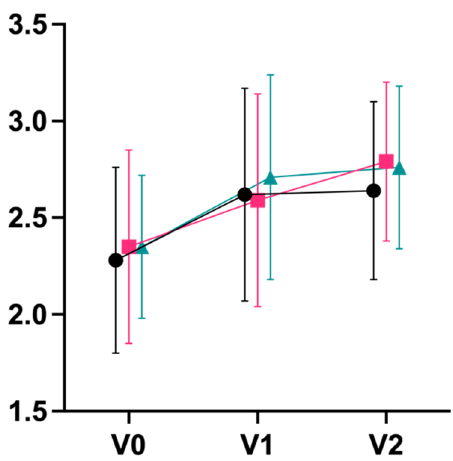
Figure 6. Physical Wellbeing B-LR (Mean ± SD).